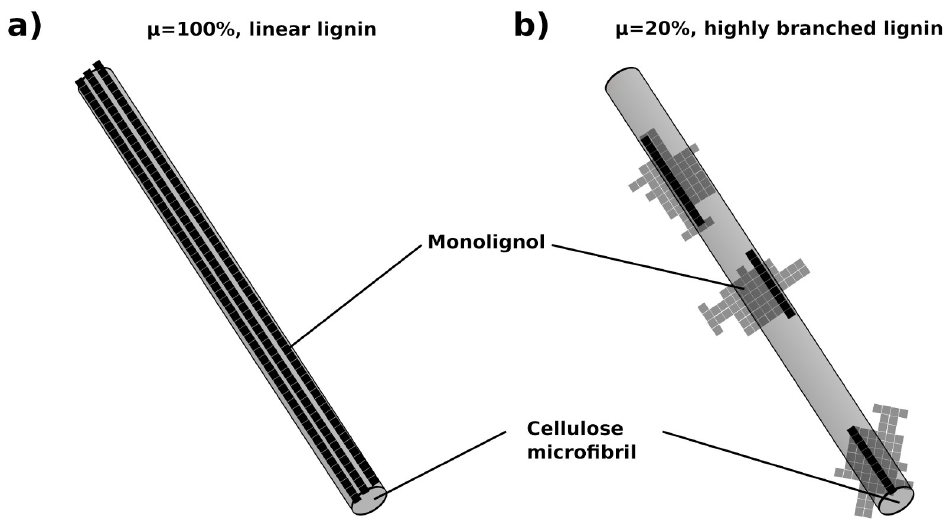
Fig 5. Sketch of the structural blocking by lignin for two different values of the covering fraction μ . (a) For μ = 100%, every bond within each lignin polymer represents a barrier. The polymers are linear. (b) For μ = 20%, only parts of each polymer represents a barrier (showed in black) while remaining monolignols are showed as shades. The polymers are highly branched.